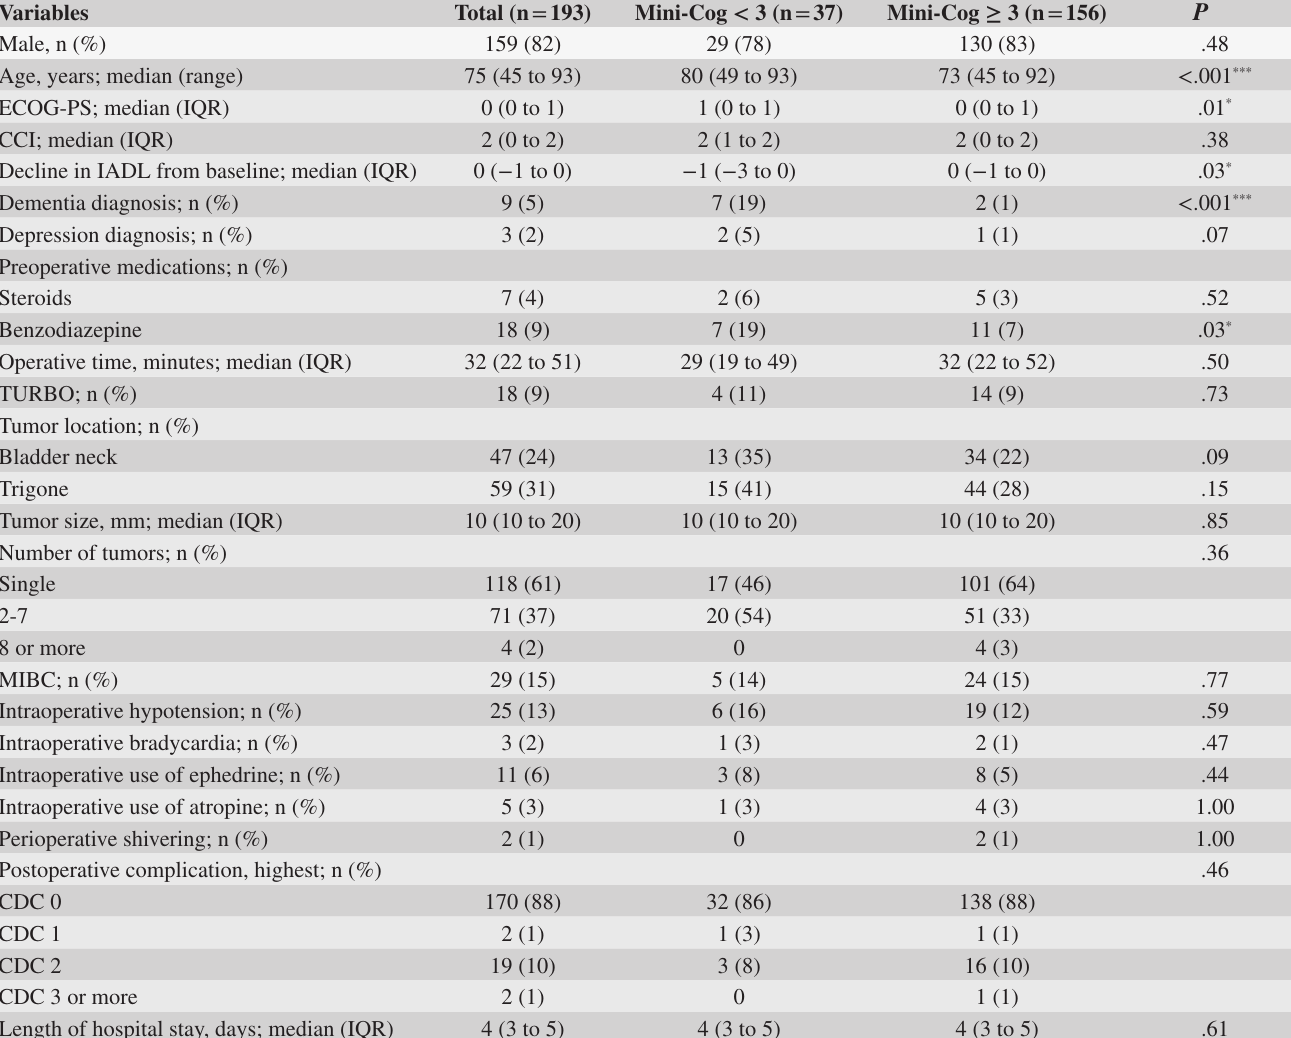
Table 1. Baseline and Perioperative Characteristics of the Patient Population Stratified by Mini-Cog